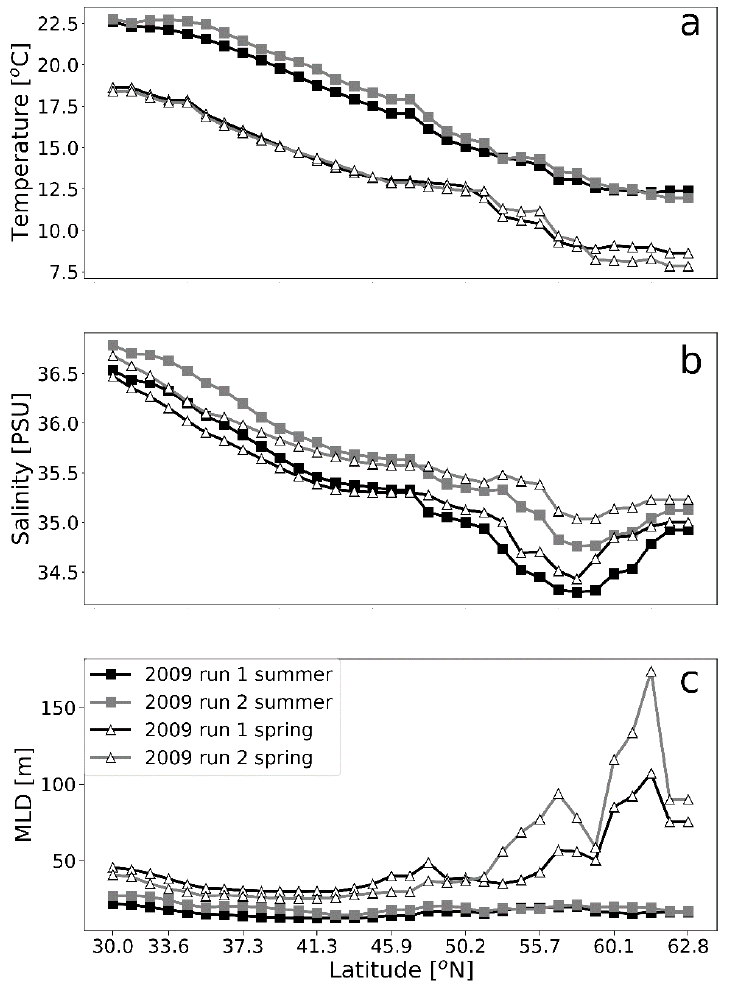
Figure 4. Sea surface temperature (SST) ( a ), sea surface salinity (SSS) ( b ), and mixed layer depth (MLD) ( c ) of NEMO run 1 and run 2. Model results are for spring 2009 (April–May averages) and